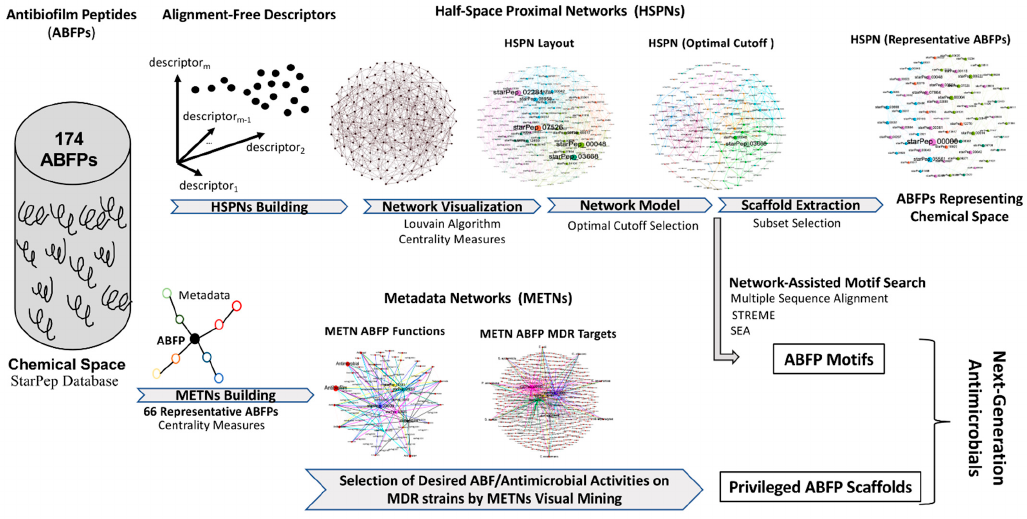
Figure 1. Overview of the proposed workflow integrating complex networks for next-generation antimicrobials’ development from ABFPs.